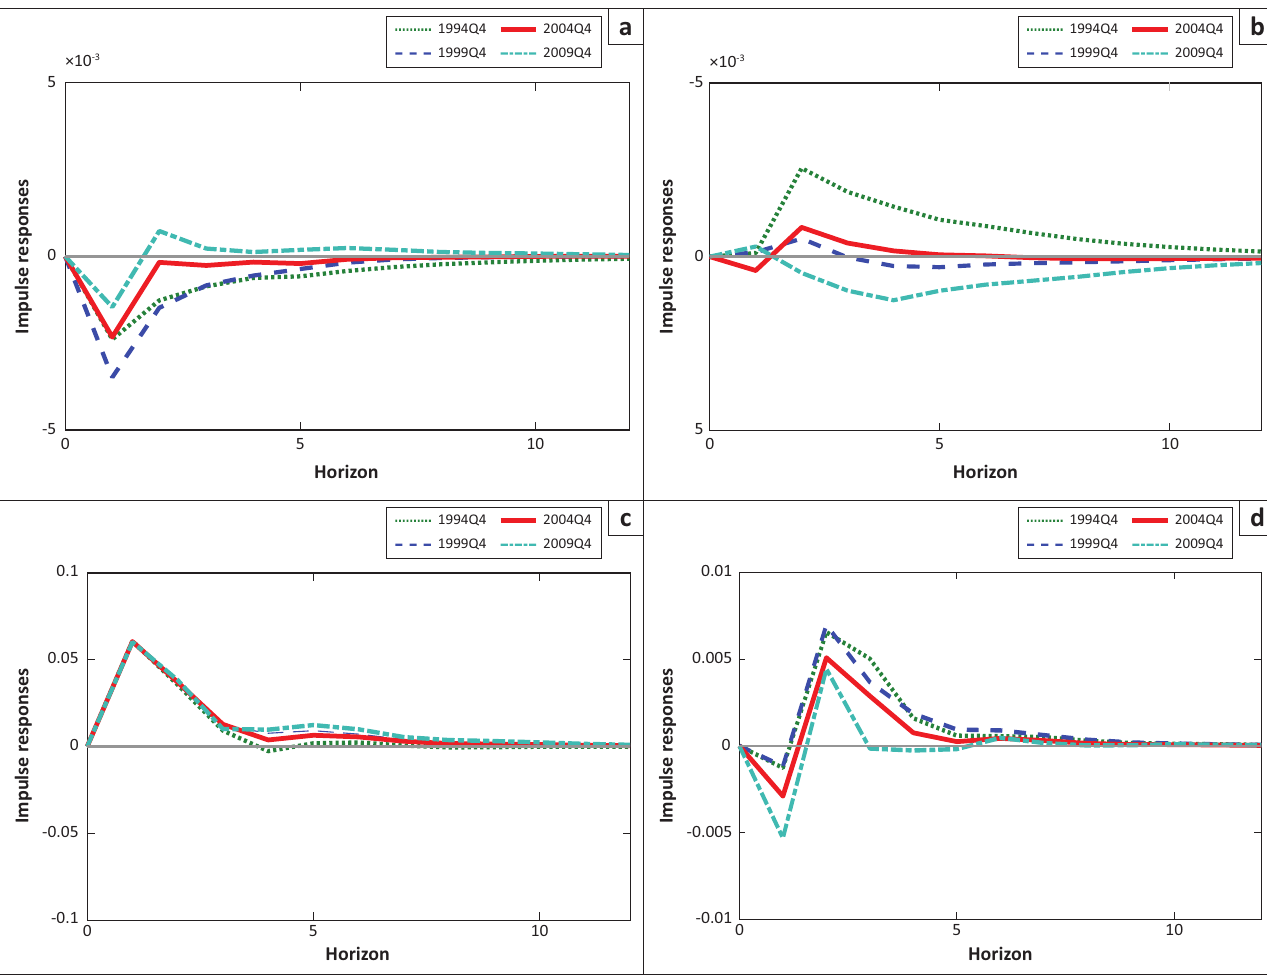
FIGURE 6: Impulse responses of selected macroeconomic variables to a positive economic policy uncertainty shock: (a) ip; (b) cpi; (c) yield; (d)